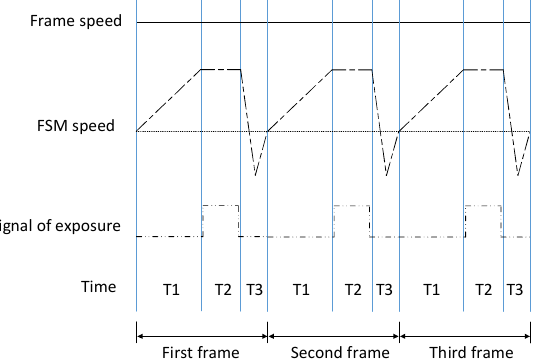
Figure 5. Timing/velocity relationships between the gimbal and the FSM; Timing diagram of the exposure trigger signal during imaging.